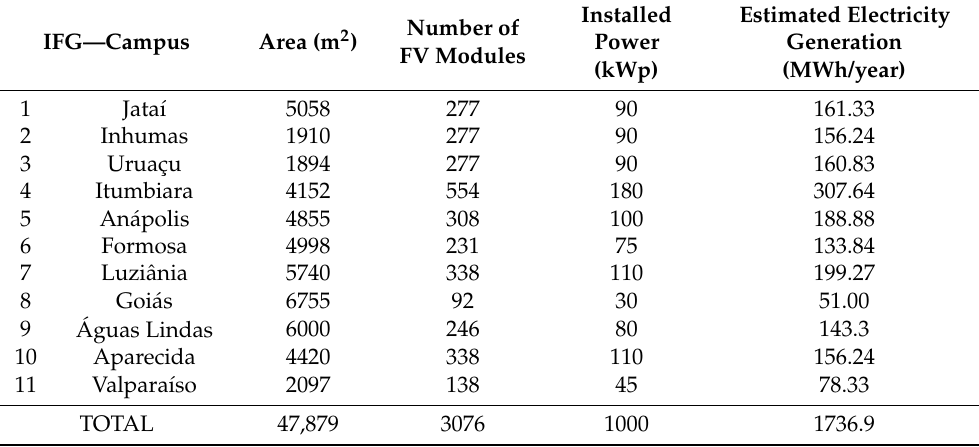
Table 9. Number of PV Modules, Installed Power, and Estimated Electricity Generation for Each